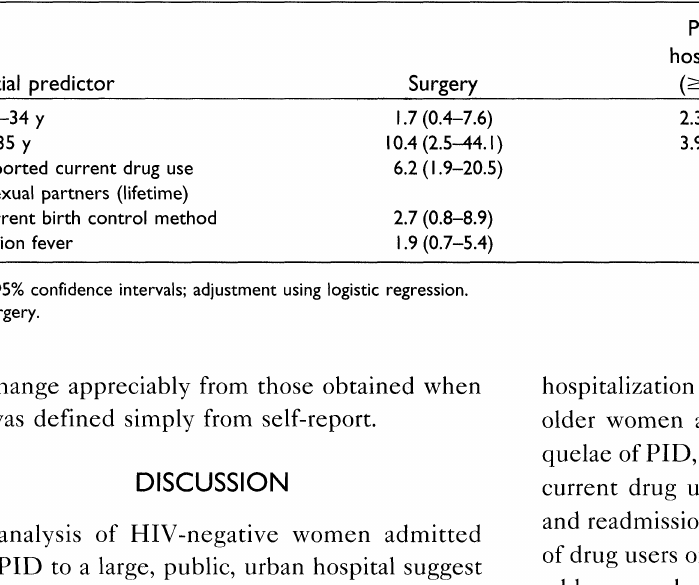
Prolonged hospitalization Readmission (>-14 days) b for PID